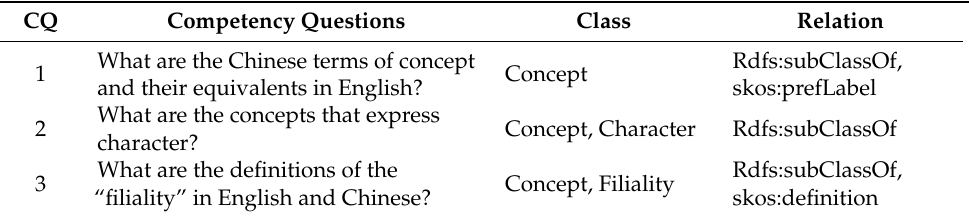
Table 1. The three competency